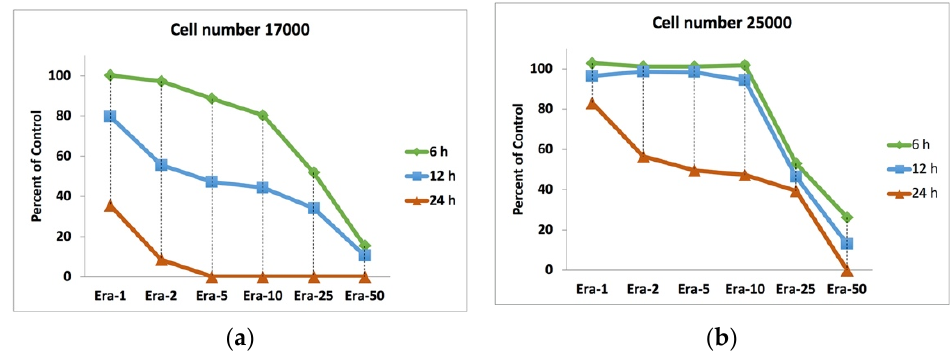
Figure 3. MC3T3-E1 cells viability for low and high cell numbers exposed to Era-0, Era-1, Era-2, Era- 5, Era-10, Era-25, and Era-50 for 2-, 4-, and 6-h: ( a ) The results from low number (17,000 cells per well) and ( b ) the results from high number (25,000 cells per well).